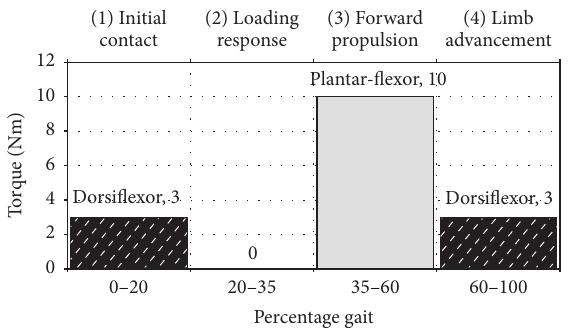
Figure 1: Dorsi- and plantar-flexor torque in no-defect